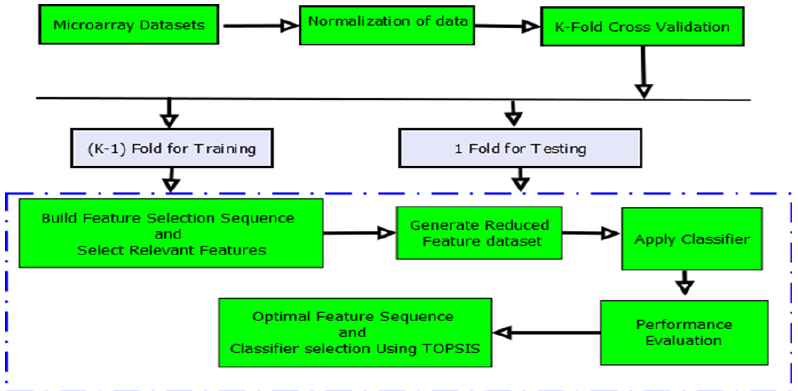
Figure 1. High-Level Flow Diagram of the Proposed